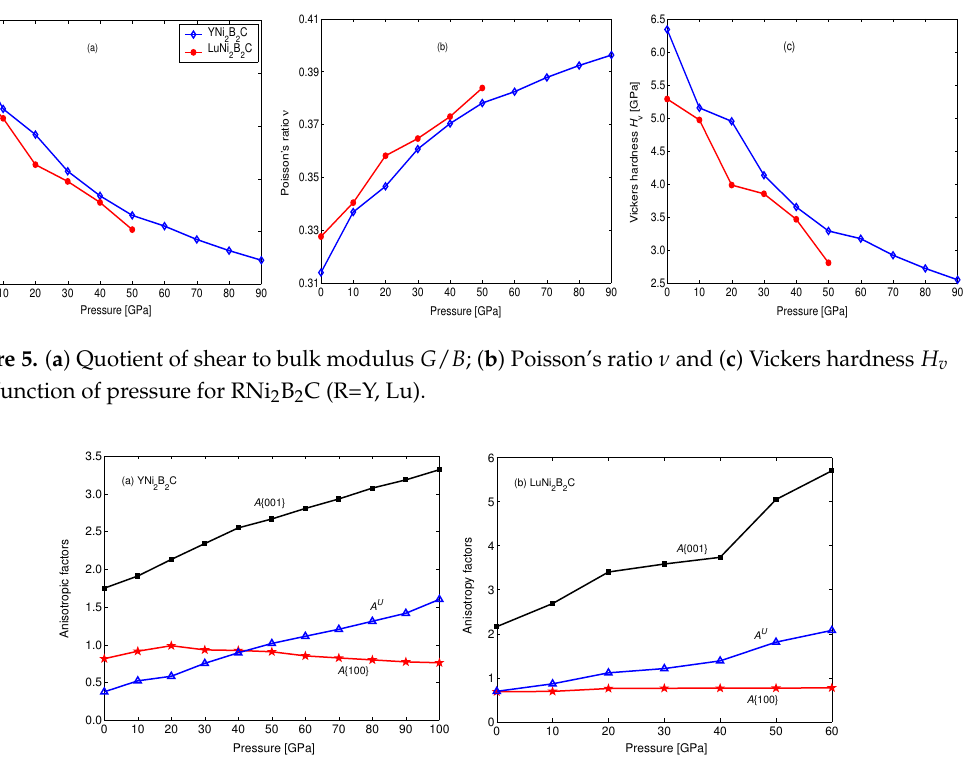
Figure 6. The pressure dependence of the shear anisotropy factors ( A { 001 } , A { 100 } ) and universal anisotropy factor ( A U ) for ( a ) YNi 2 B 2 C and ( b ) LuNi 2 B 2 C,